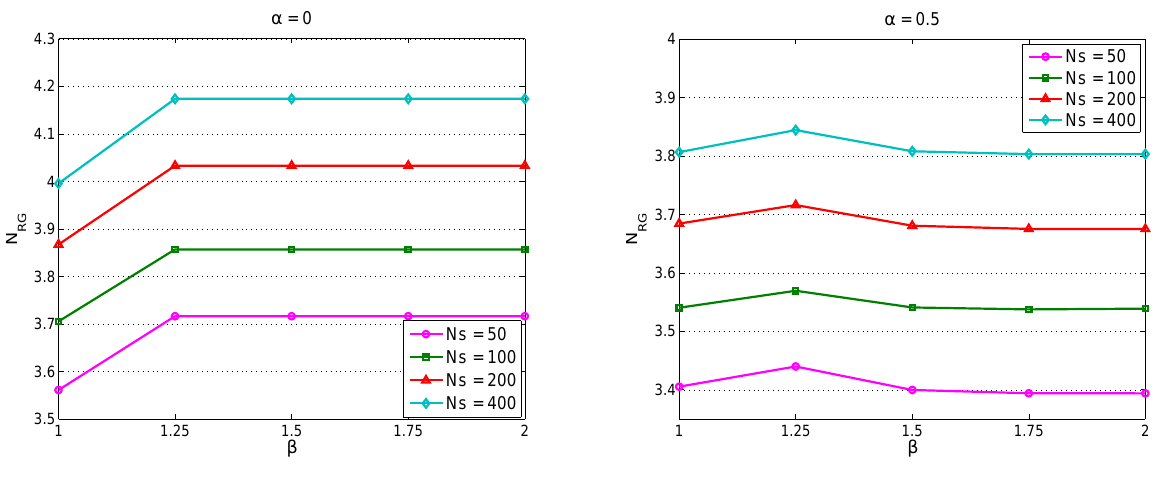
Figure 9. The number of sensing rounds N with α = 0 . 5